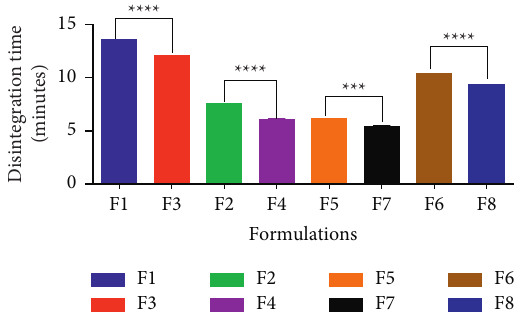
Figure 1: Statistical analysis of the disintegration time of for- mulated tablets using Student’s two-tailed